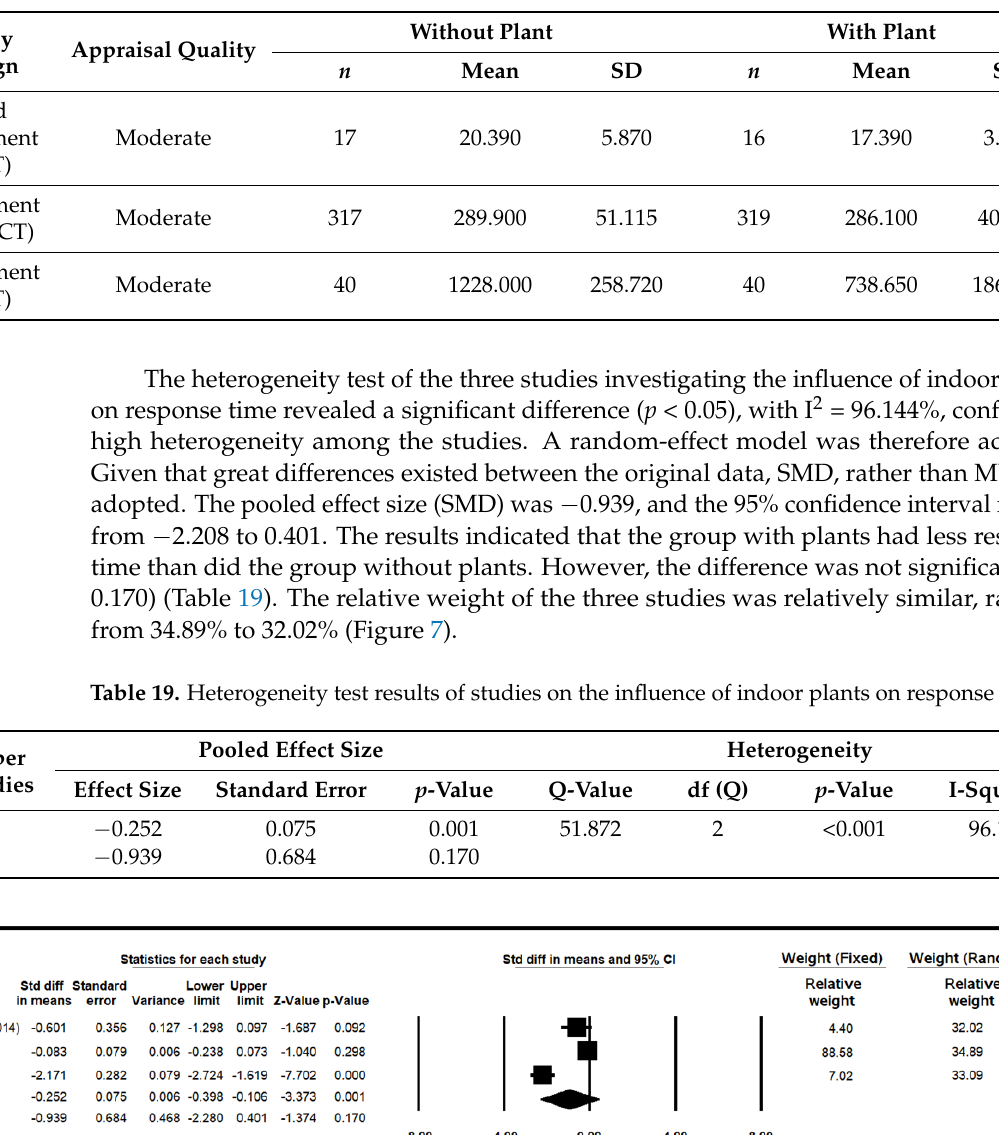
Table 18. Original data of the studies examining the influence of indoor plants on response time.